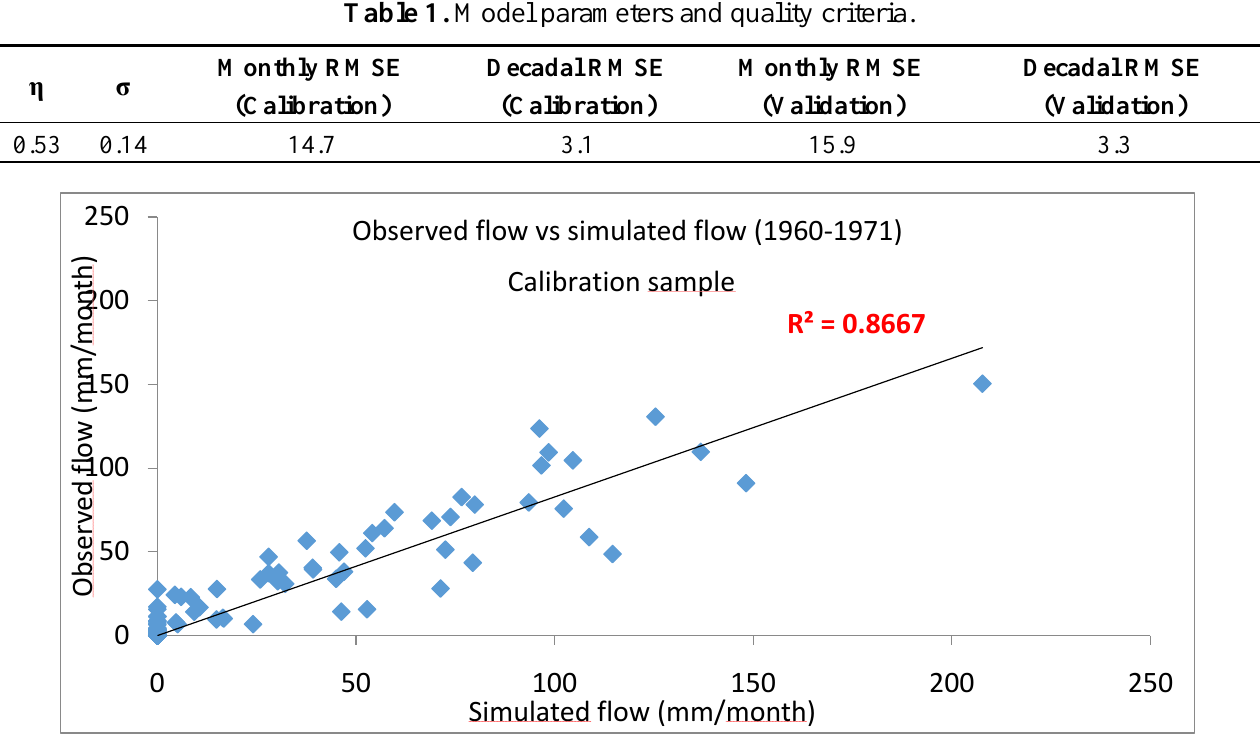
Figure 2. Scatter plot of observed and predicted monthly runoff for calibration